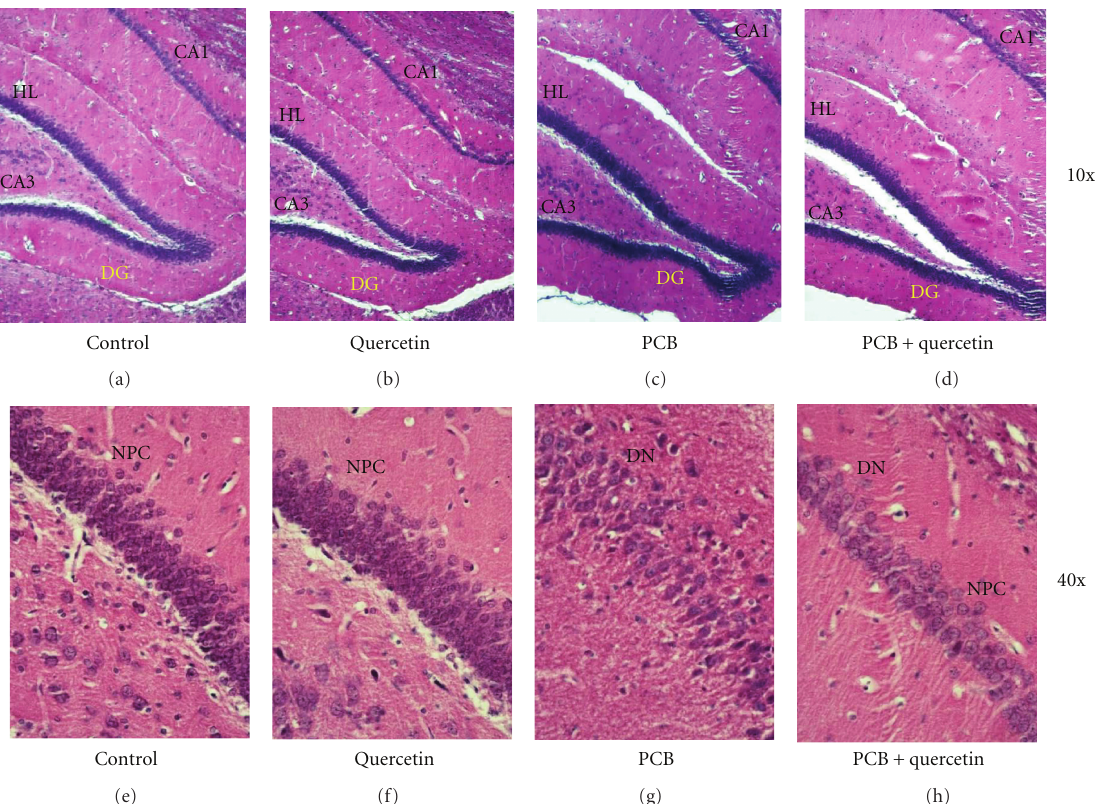
Figure 9: Photomicrograph of the hippocampal pyramidal cell layers in Control, Quercetin, PCB, and PCB with Quercetin Treated rats. Histology of hippocampus in PCBs-exposed adult rats. Figures (a), (b), (c), (d) are 10x magnification, (e), (f), (g), and (h) are 40x magnification. The normal pyramidal cells (NPC) of hippocampal layer are normal in control rats (a) (e) and quercetin alone treated rats (b) (f). Degeneration of pyramidal cells is observed in PCB-treated rats (c) (10x). Degenerative neurons (DNs) as well degenerative layers are also observed in PCB-treated rats (40x) (g). Restoration of pyramidal cells in both 10x and 40x magnifications (d) (h) few degenerated pyramidal cells are also seen (d) (h). (Haematoxylin and Eosin staining 10x/40x). HL- Hippocampal Layer DN- Degenerative Neurons NPC- Normal Pyramidal Cell DG- Dentate gyrus CA1, CA3- Cornus Ammonis 1, Cornus Ammonis